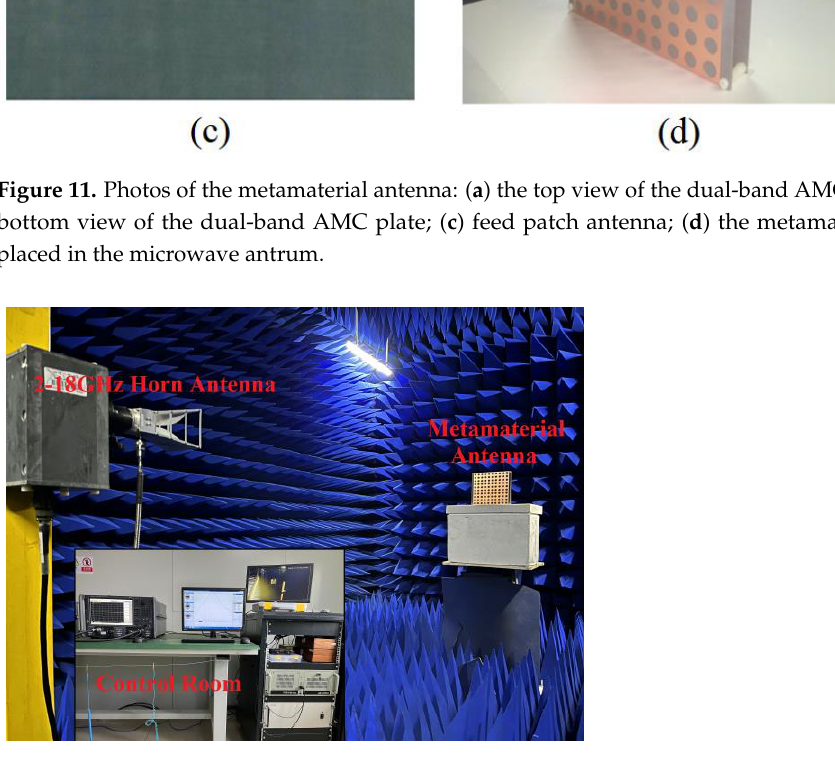
Figure 12. The test environment of the antenna .